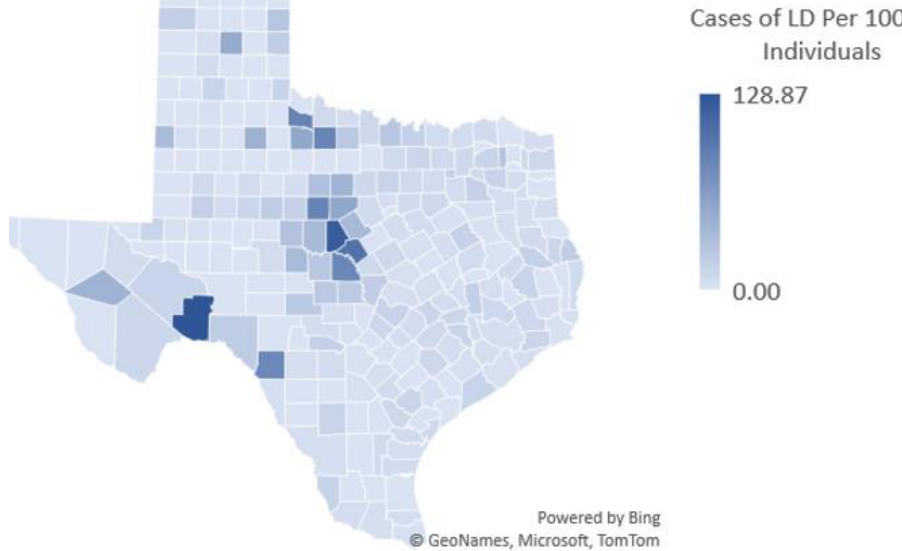
Figure 3. CDC Lyme disease case reports from 2000 to 2018 by population